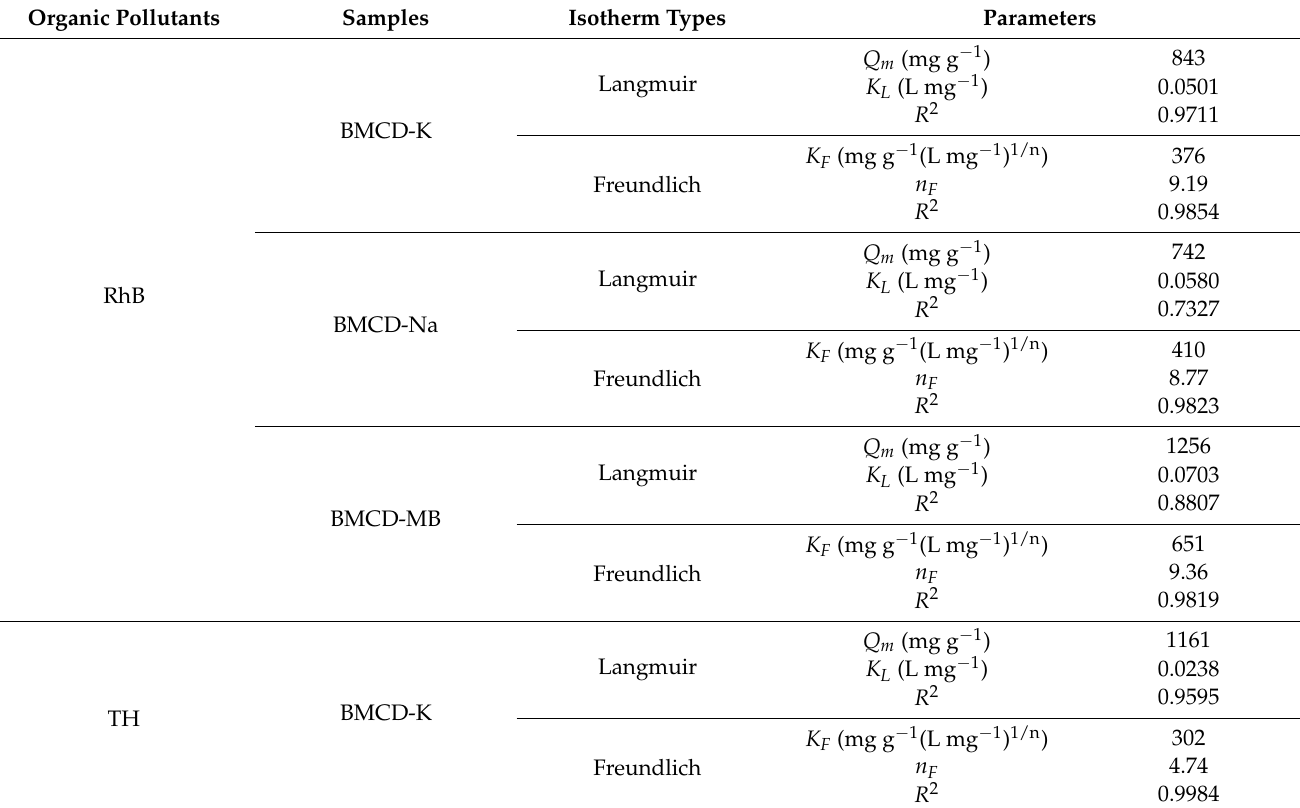
Figure 7. The adsorption isotherm plots of BMCD-K, BMCD-Na, and BMCD-MB for ( A ) RhB and ( B ) TH at 303 K. Table 3. Fitting parameters of adsorption isotherm models for RhB and TH at 303 K.